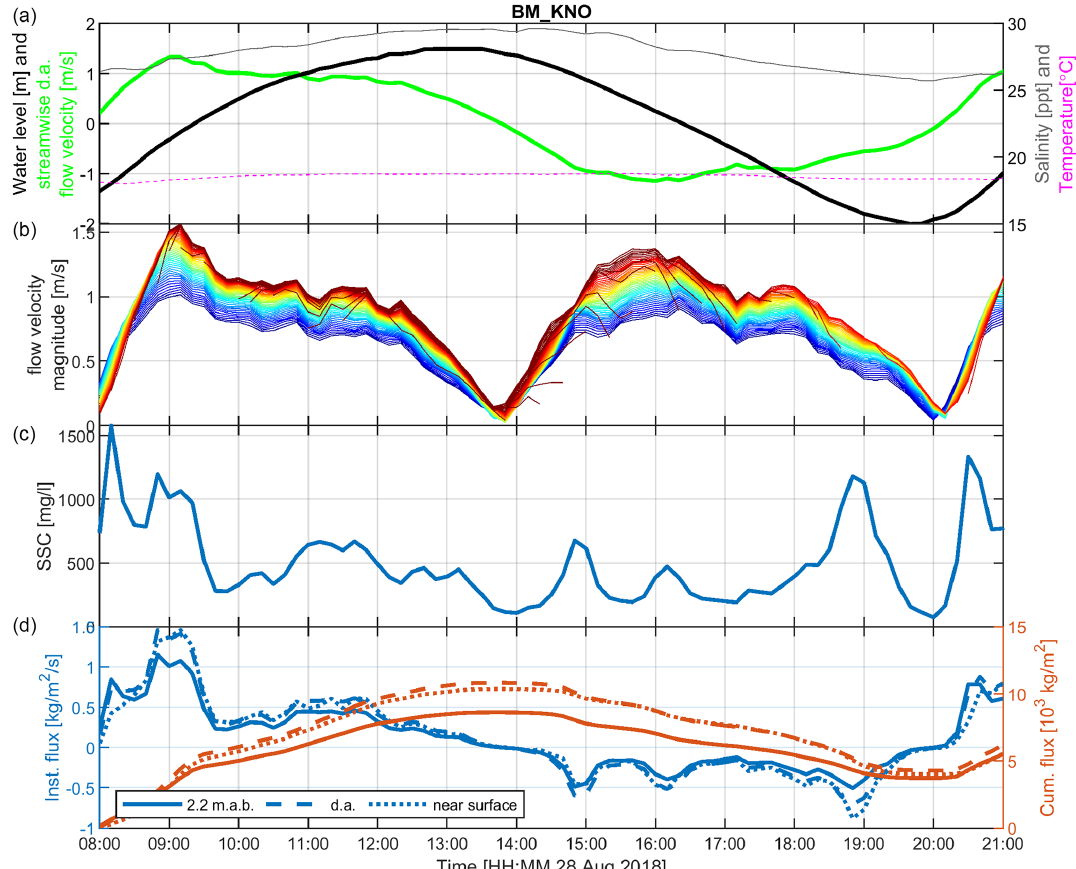
Figure 11. Tidal cycle observations at Knock (BM_KNO), showing the water level (black), salinity (grey), depth-averaged flow velocity (green) and temperature (pink, a ), the depth-varying flow velocity (red near the surface, blue near the bed, b ), the sediment concentration near the bed (c) , and instantaneous and cumulative sediment flux (landwards positive; d ).